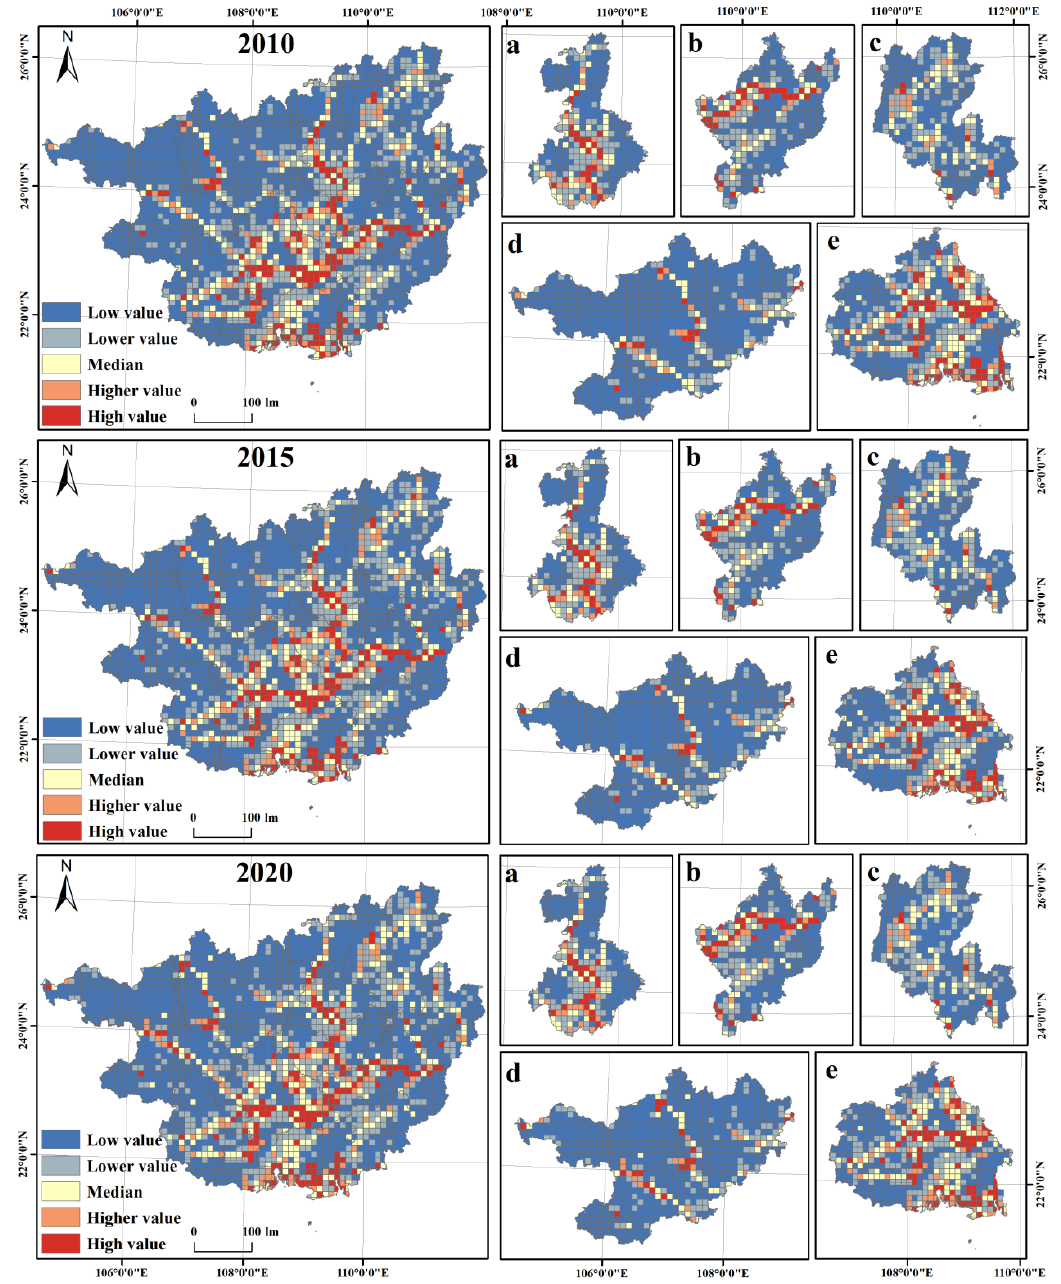
Figure 5. Economic value grid distribution map of Guangxi and each consolidation area. (Note: ( a ) is the middle karst basin area of Guangxi, ( b ) is the southeast plain area of Guangxi, ( c ) is the northeast hilly mountain area of Guangxi, ( d ) is the northwest mountain area of Guangxi, ( e ) is the coastal hilly plain area.)